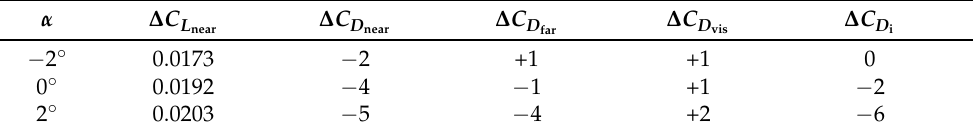
Table 10. Comparison between IB-OB-1 and OFF configurations at Re ∞ = 16.6 × 10 6 , M ∞ = 0.480. Breakdown of the drag polars with spurious drag detection; induced drag computed by Maskell’s